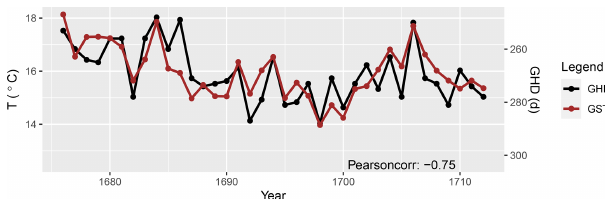
Figure 4. Comparison between GST of T m in Paris and the grape harvest dates (GHDs) from Beaune (Labbé et al., 2019) in the LMM. The Pearson correlation index equals a value of − 0 .